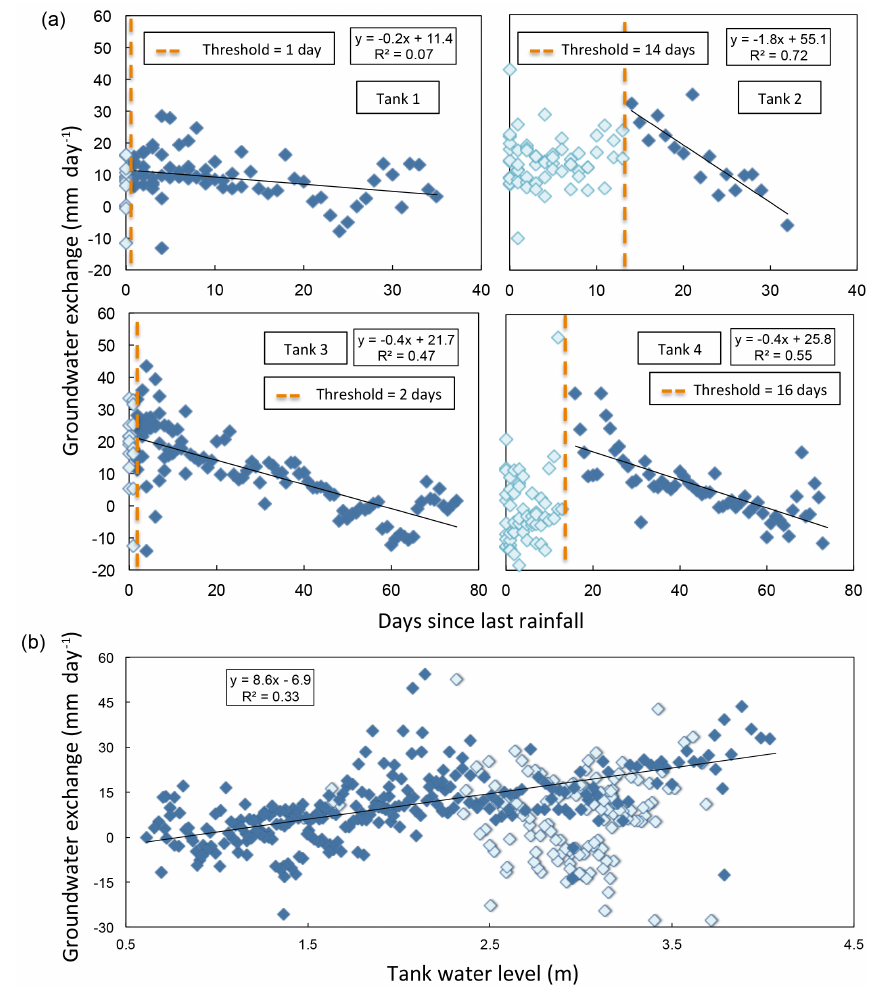
Figure 8. (a) Relationship between groundwater exchange and days since last rainfall, shown separately for the four tanks. The threshold line (dashed orange) separates the more erratic rainfall-driven groundwater exchange behavior following rain events (shown as light blue diamonds) from the more predictable behavior typical of drier periods (shown as dark blue diamonds), when GE is driven primarily by hydraulic head values determined by tank water levels. (b) Relationship between tank water levels and groundwater exchange shown for all four tanks combined. Lighter blue diamonds correspond to the rainfall values below the threshold shown above in Fig.